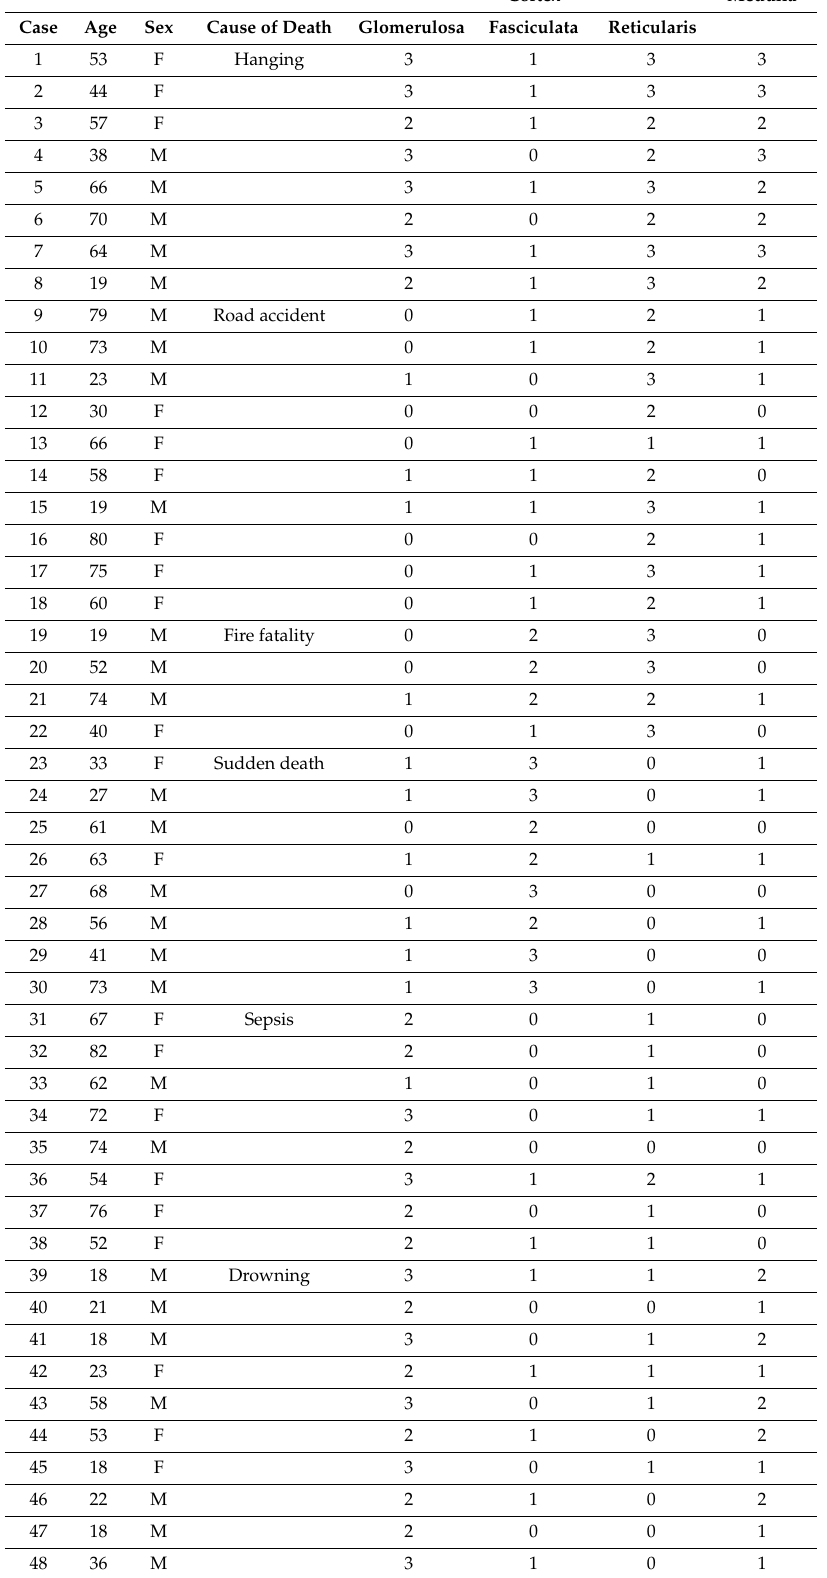
Table 1. Age, sex, cause of death, adrenal cortical scores and adrenal medullary scores in the case series. Cortex